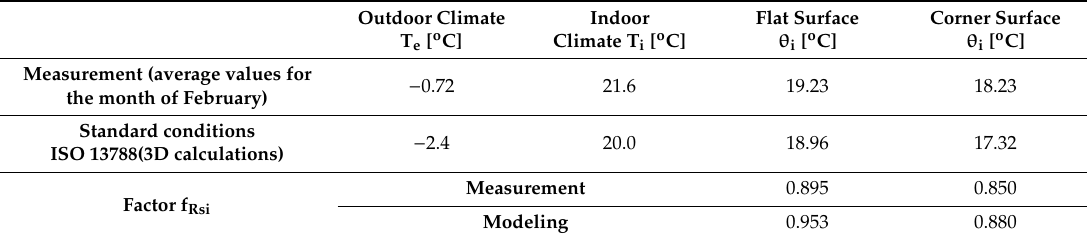
Table 3. Calculation results for the variant 2